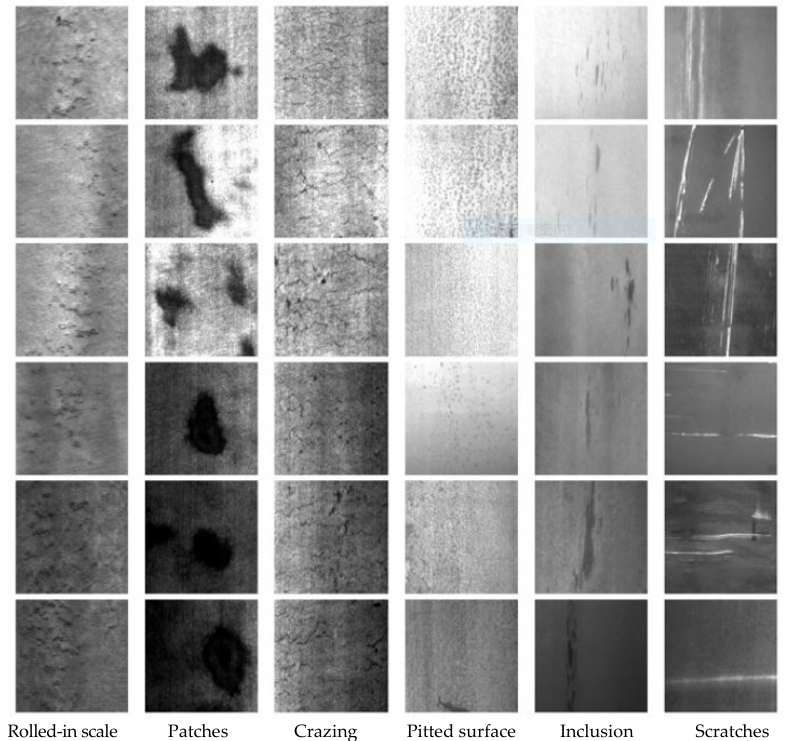
Figure 3. Examples of steel defects (reproduced from Song [16]).